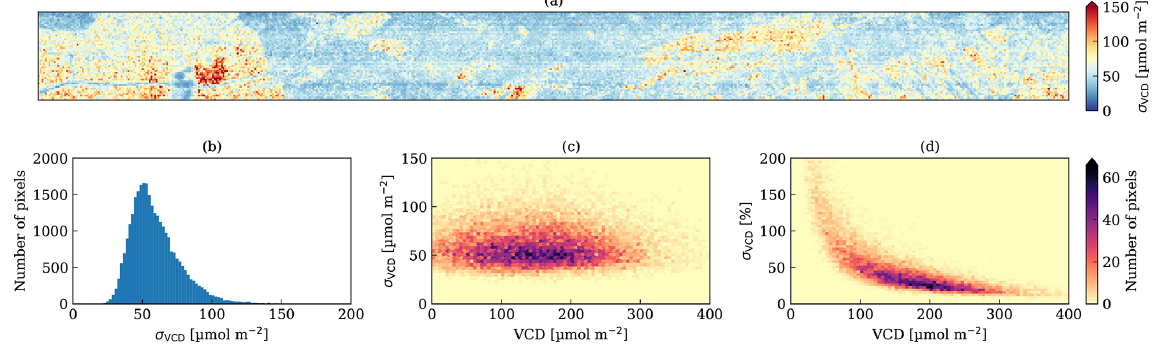
Figure 8. Estimated uncertainty of NO 2 VCDs for the second APEX stripe showing (a) the spatial distribution (see Fig. 1) and (b) the distribution of uncertainties and the dependency on the NO 2 VCDs of the (c) absolute and (d) relative